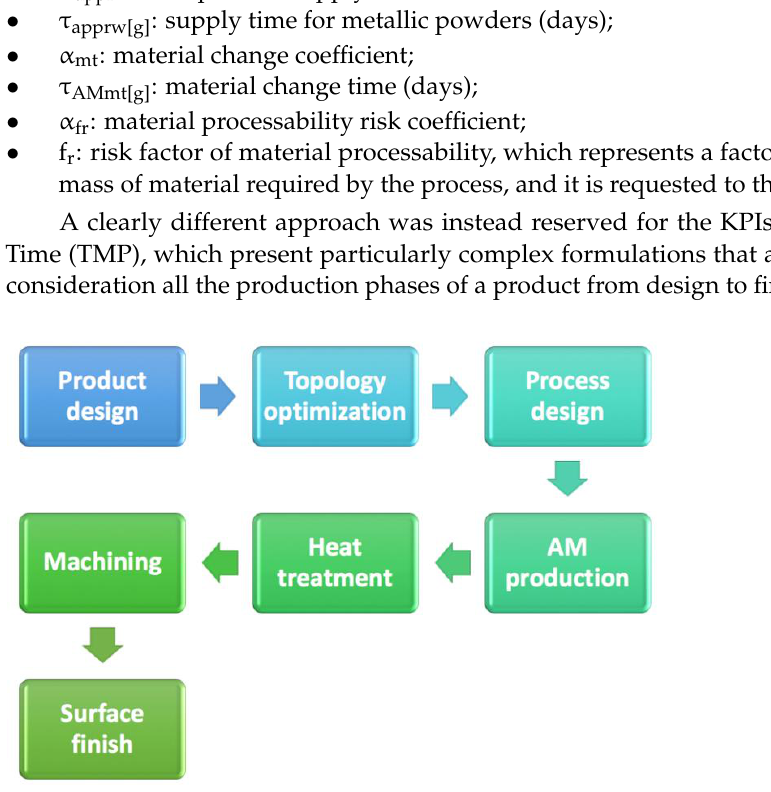
Figure 3. List of production phases considered for the Cost KPI (CST) and Time KPI (TMP) calcu-